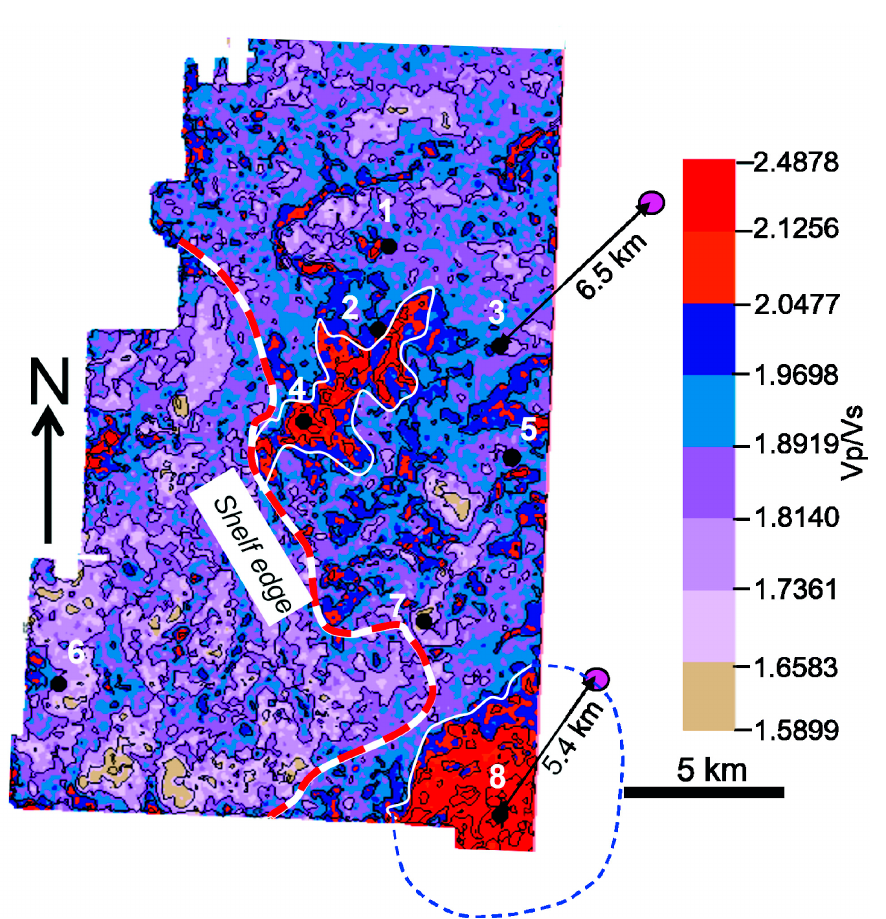
Figure 11. Inverted Vp/Vs ratio extracted at top Strawn horizon. Note: combined dashed red and dashed white line = shelf edge. Areas west of shelf edge characterized by low-Vp/Vs ratio and by mostly pale-magenta, tan, and some dark-magenta. Areas east of shelf edge characterized by high-Vp/Vs ratio. Prominent two red zones defined by white outline just east of shelf edge = reefs, characterized by high-Vp/Vs ratio. Refer to text for details. Numbers (in white) indicate well names.